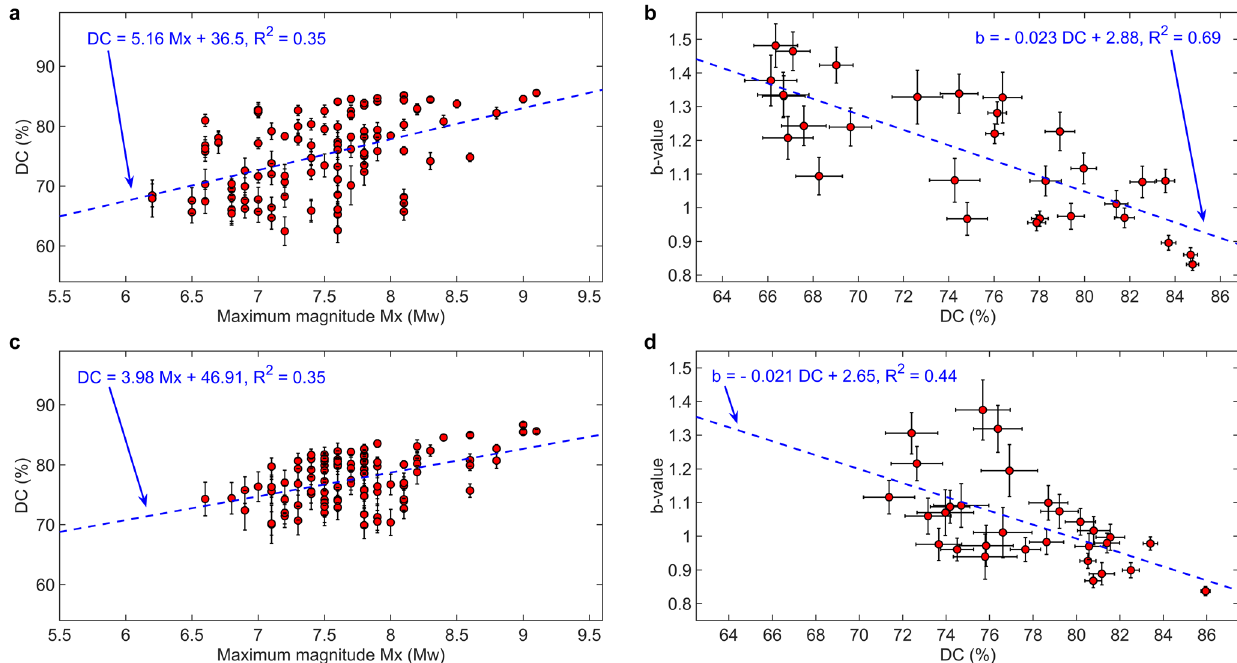
Fig. 2 Correlations between double-couple component and maximum magnitude and b-value of the Gutenberg-Richter distribution. Double-couple trends as a function of the magnitude of the largest event in the sets for the GCMT and ISC catalogues ( a , c ). b -value as a function of the average double- couple of the earthquakes of each set ( b , d ). ( b , d ) suggest that normal-faulting earthquakes have lower double-couple components than strike-slip and thrust-faulting events at a global scale. Error bars stand for σ